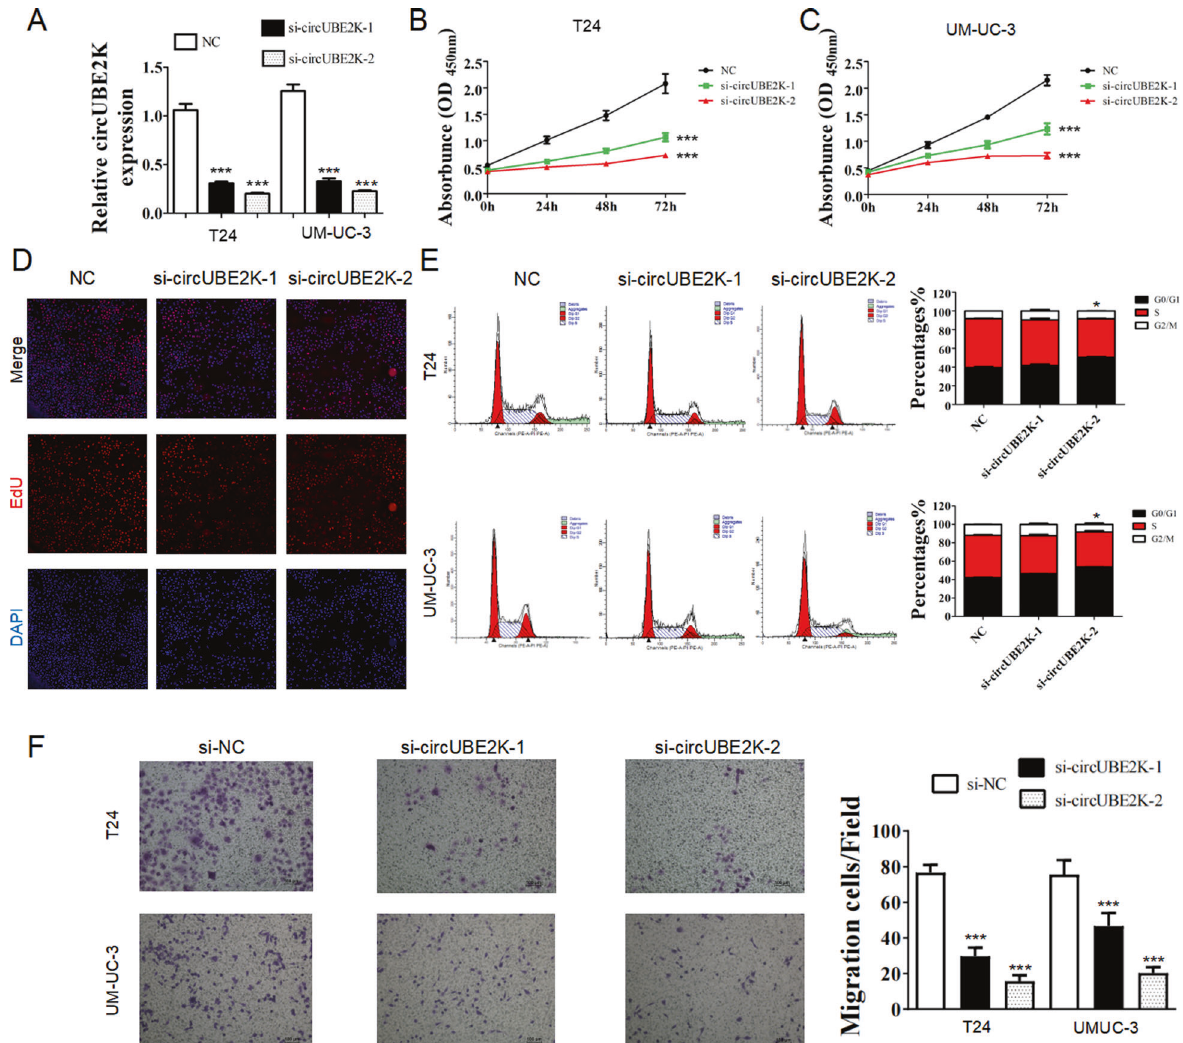
Cell Death and Disease (2022)